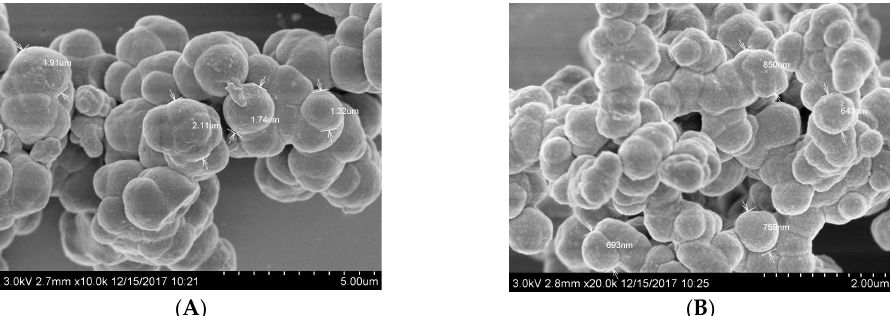
Figure 2. SEM images for both ( A ) cytarabine molecularly imprinted polymer (MIP) and ( B ) non-imprinted polymer (NIP) beads.